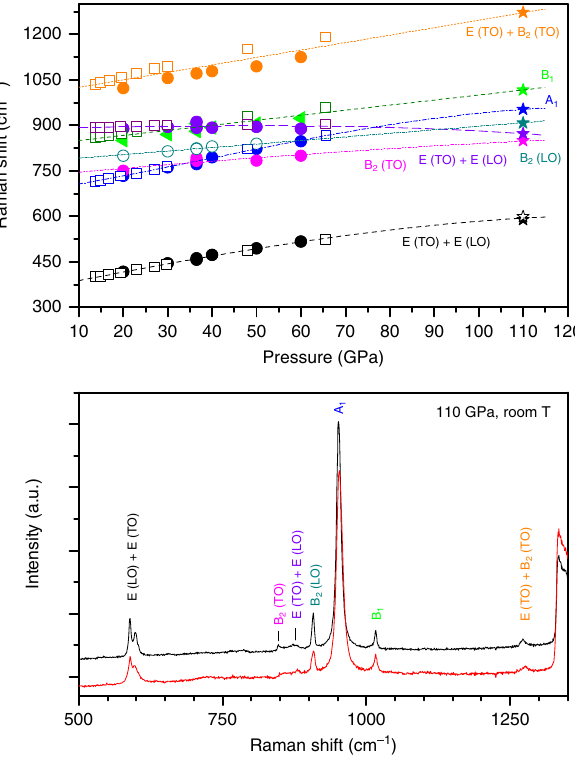
Fig. 4 Raman data. The data sets are acquired in two different points of the sample at ~110 GPa after quenching to room temperature with the mode assignment (bottom panel). Pressure dependence of the frequencies of Raman modes (top panel). Empty symbols — experimental data 12 , full symbols — calculations 17 , asterisks — this